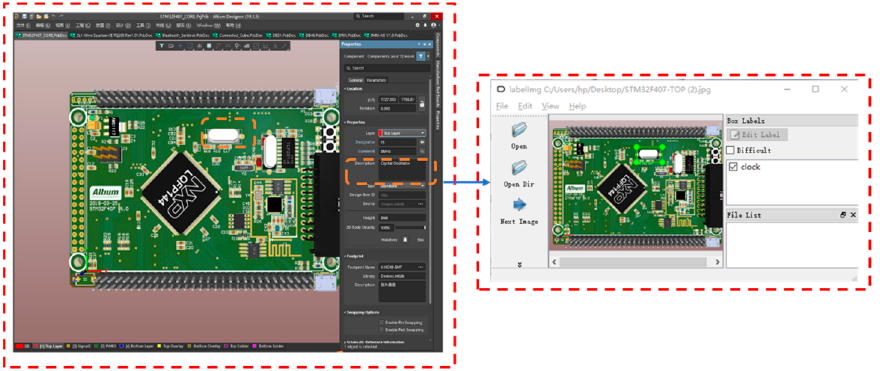
Figure 4. Display query and label of virtual image with synthesized data.